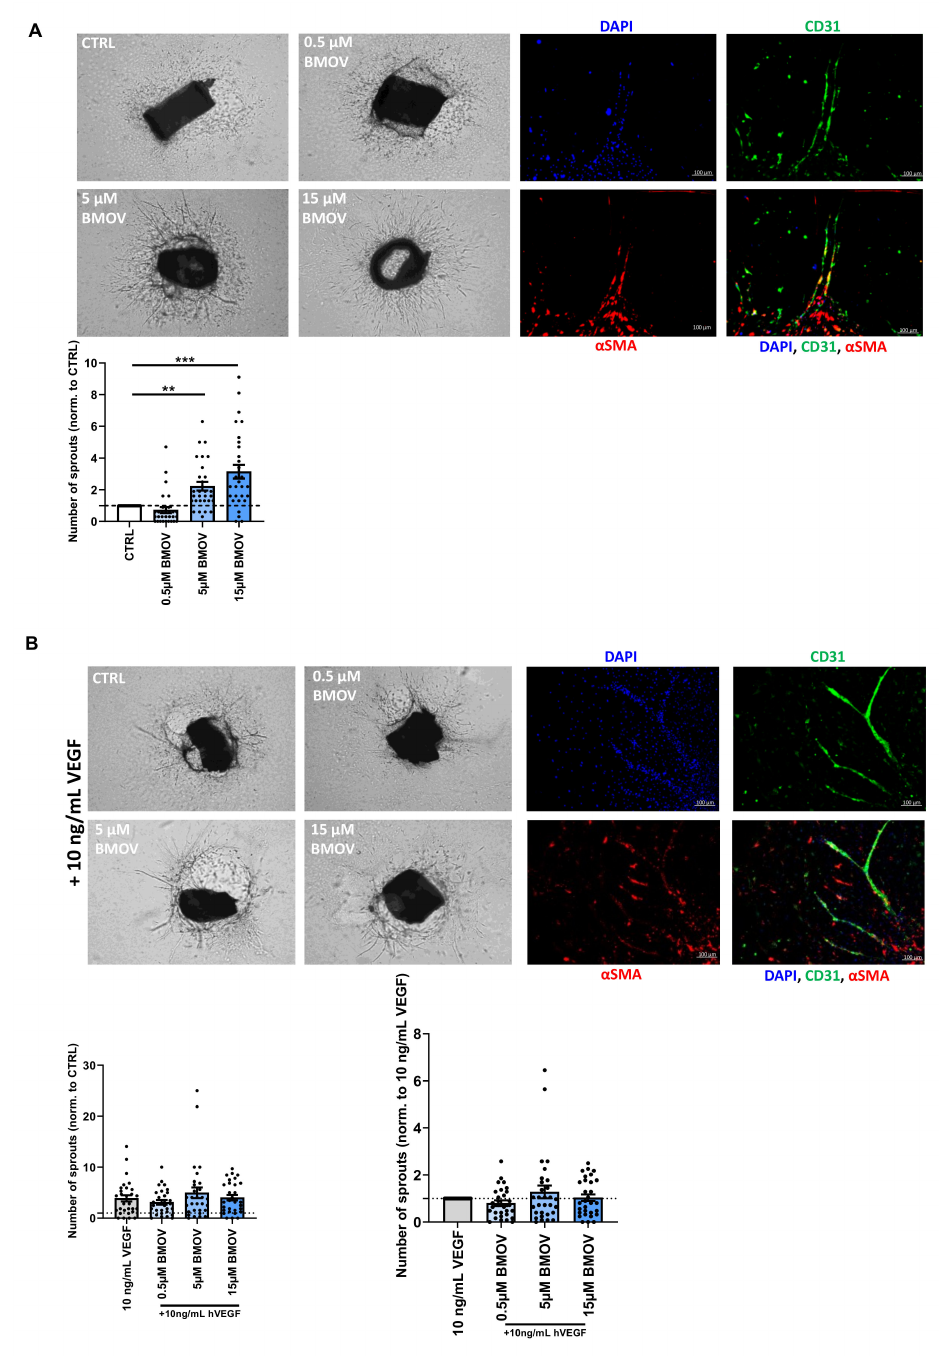
Figure 7. Representative images (top) and quantification of neovessel sprouts (bottom) after treatment with either ( A ) BMOV alone in di ff erent concentrations (0.5, 5, 15 µ M) or ( B ) di ff erent concentrations of BMOV (0.5, 5, 15 µ M) supplemented with 10 ng / mL VEGF-A in an ex vivo aortic ring assay. Top right panels of ( A , B ) are representative examples of complex aortic ring neovessel sprouts fluorescently stained with cell specific markers. CD31 (green) stains endothelial cells; α -SMA (red) indicates smooth muscle cells; DAPI-stained nuclei (blue). (C) E ff ect of BMOV in the tissue culture supplemented with 10 ng / mL VEGF-A. Datapoints are presented as mean ± SEM. ** p < 0.01; *** p < 0.001 by Kruskal-Wallis